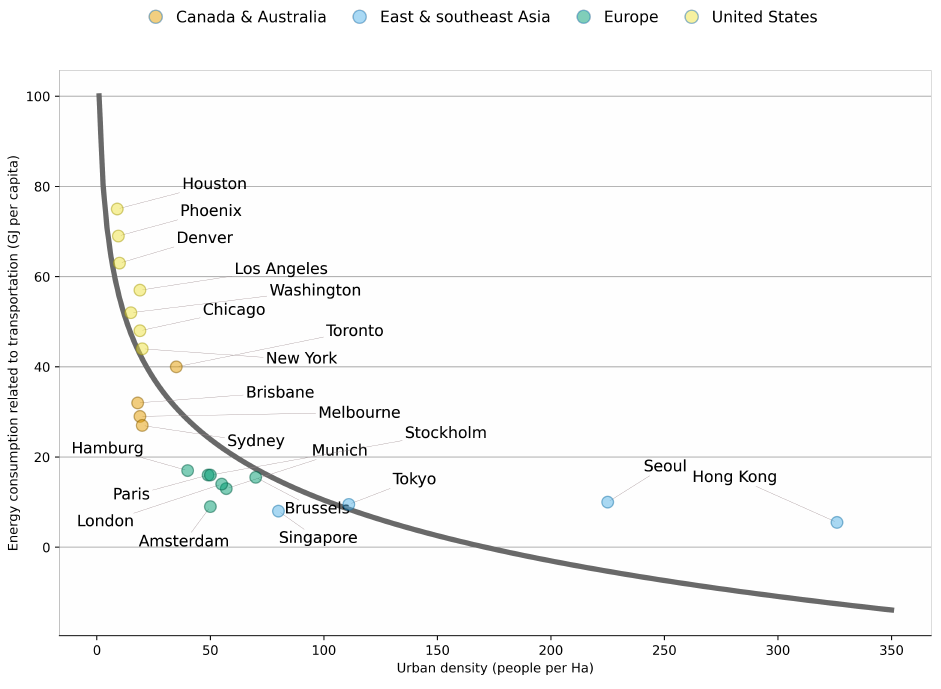
Figure 4. Urban density and energy